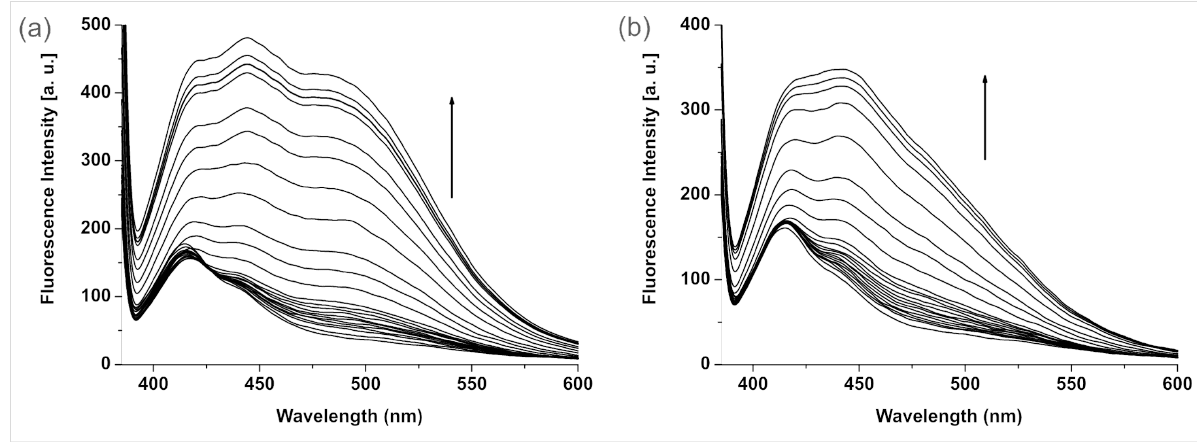
Figure 4: Change in emission of 1 ( c = 4.31 × 10 − 5 M) upon gradual addition of tetrabutylammonium salts of (a) L- N- acetylvaline and (b) L- N- acety- lalanine.